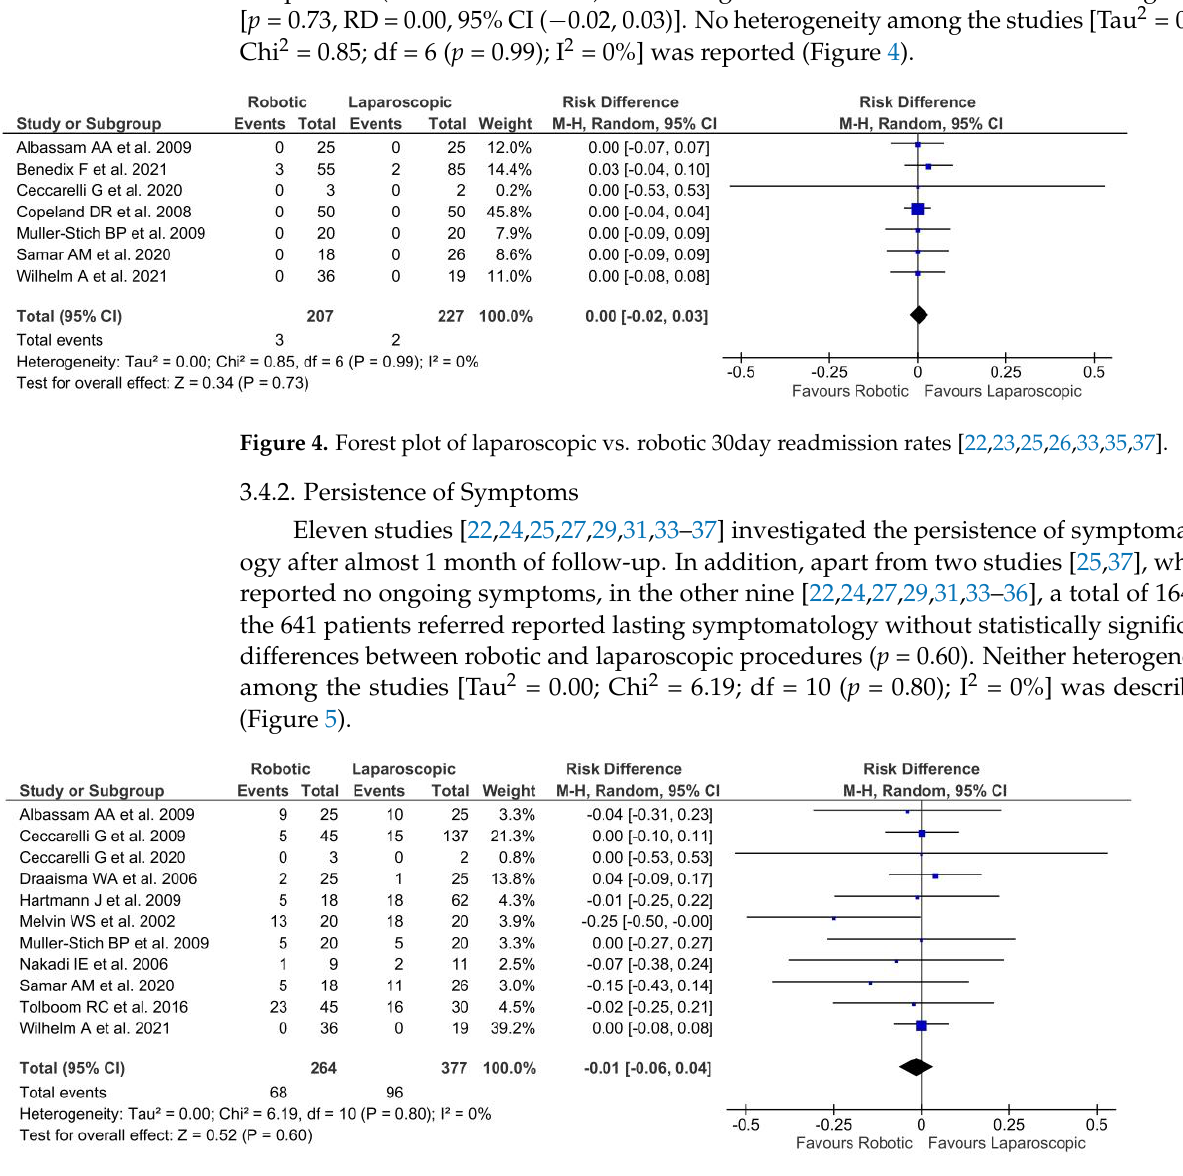
Figure 5. Forest plot of laparoscopic vs. robotic persistence of symptomatology